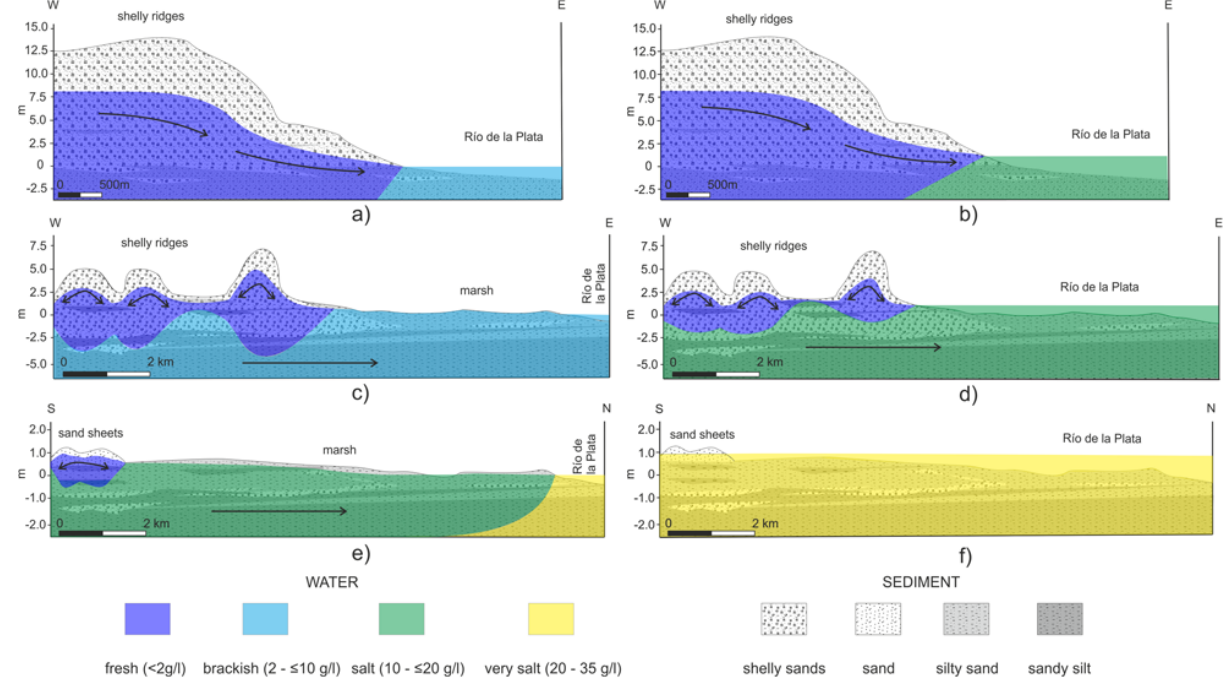
Fig. 9. Hydrogeologic conceptual models along representative cross sections of the Samboromb´on Bay. Present setting: (a) northern sector, (c) central sector, and (e) southern sector. Expected changes induced by ∼ 1m RSLR: (b) northern sector, (d) central sector, and (f) southern